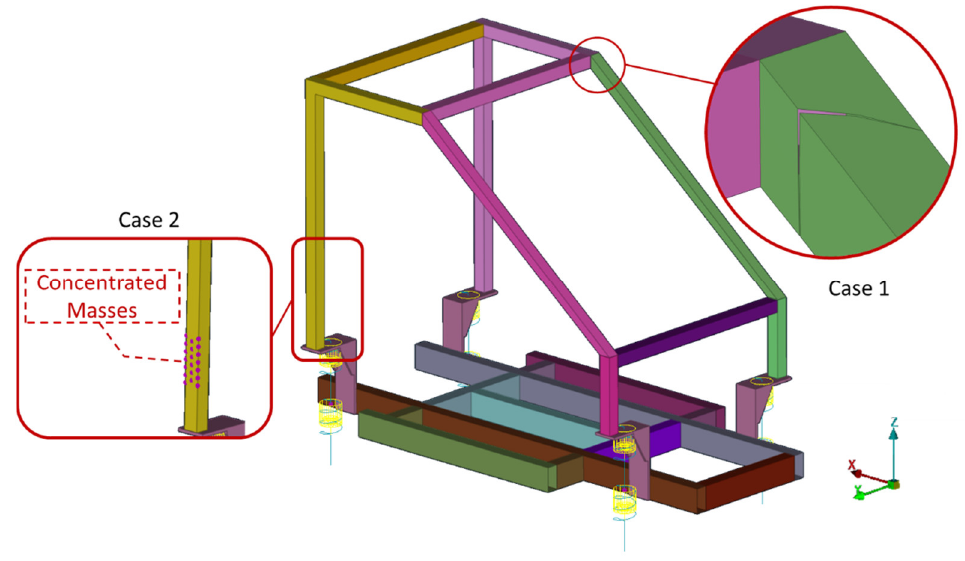
Figure 7. SEFEM damage Cases 1 and 2.